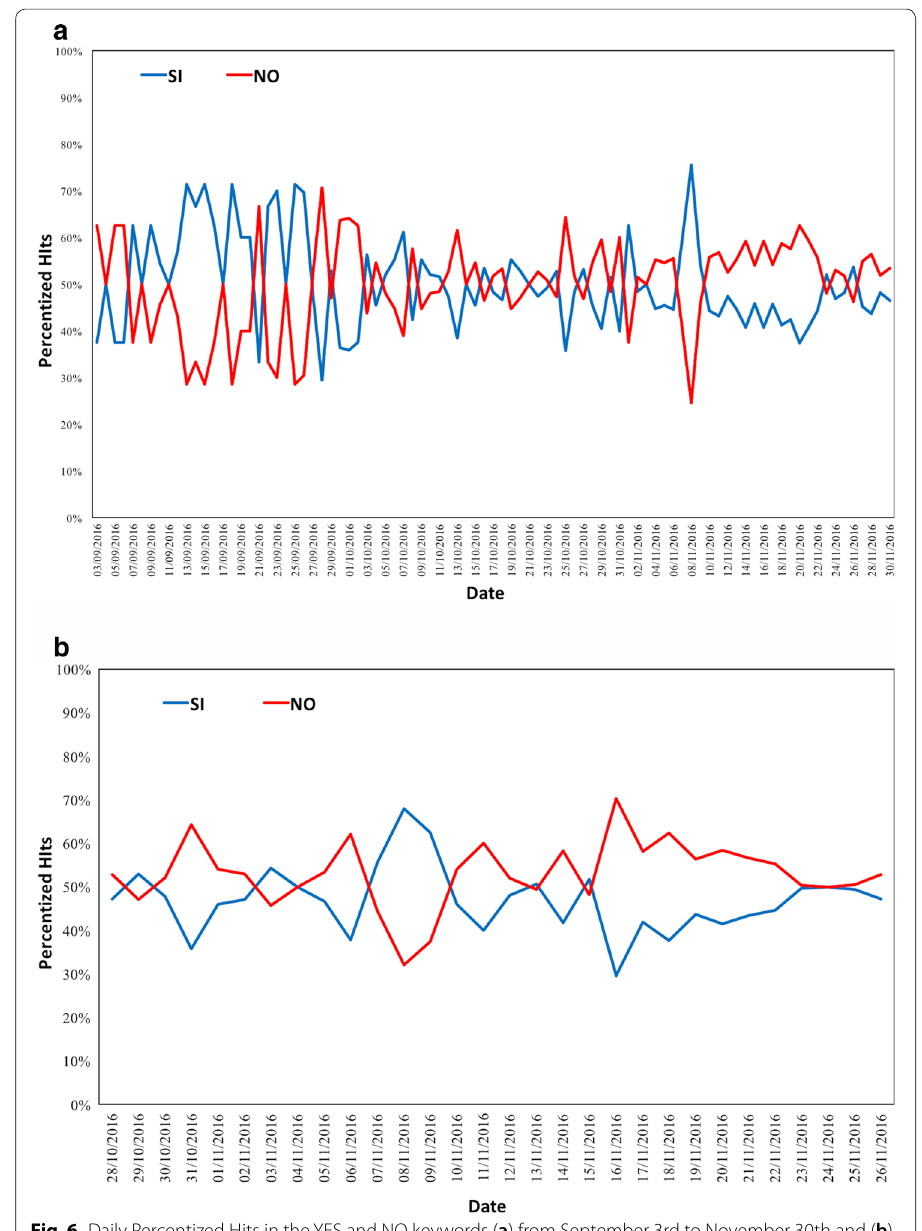
Fig. 6 Daily Percentized Hits in the YES and NO keywords ( a ) from September 3rd to November 30th and ( b ) from October 28th to November